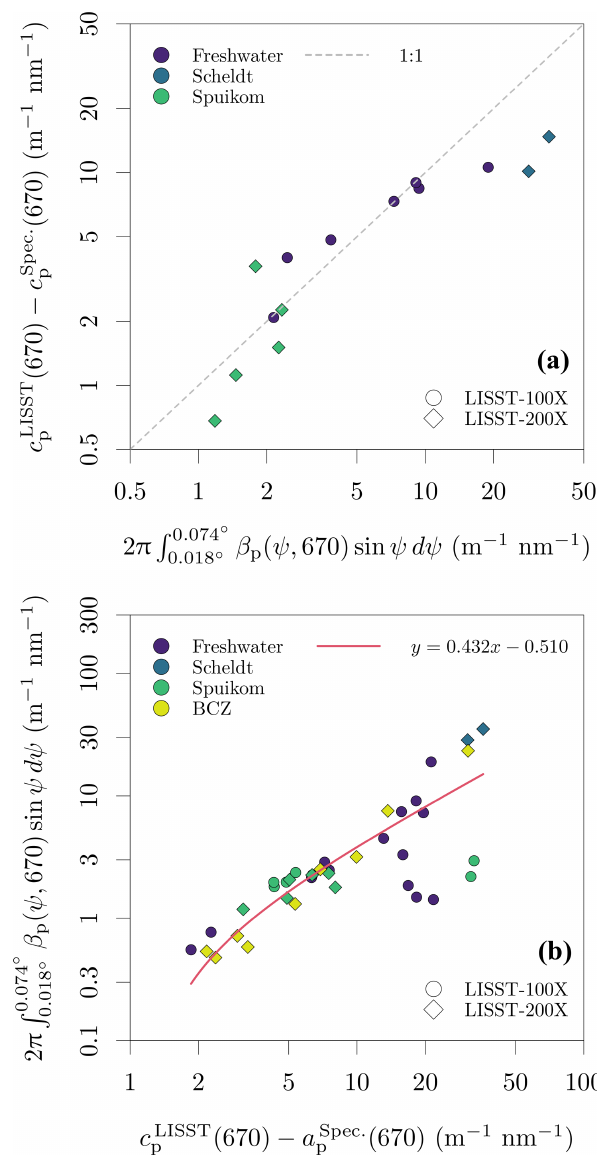
Figure 6. Evaluation of c p measurement bias due to the finite ac- ceptance of the spectrophotometer. (a) Relation between the differ- ence of the c p measured with the spectrophotometer and the LISST, and the VSF integral in the range of solid angles defined by the dif- ference of their acceptance angles. (b) Relation between the scatter- ing coefficient ( b p = c p − a p ) and the magnitude of scattering be- tween 0.018 and 0.074 ◦ scattering angles ( ψ